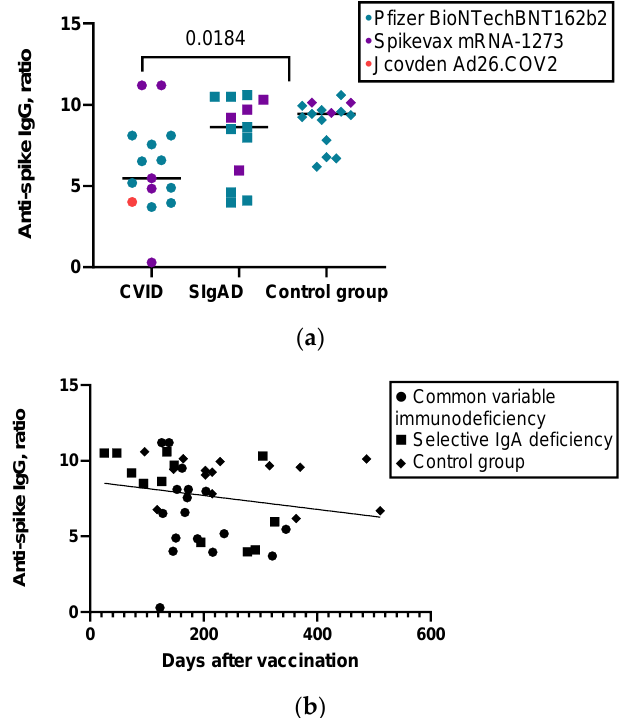
Figure 1. ( a ) Levels of anti-spike IgG antibody levels in different groups; ( b ) correlation between anti-spike IgG antibody levels and days after vaccination .